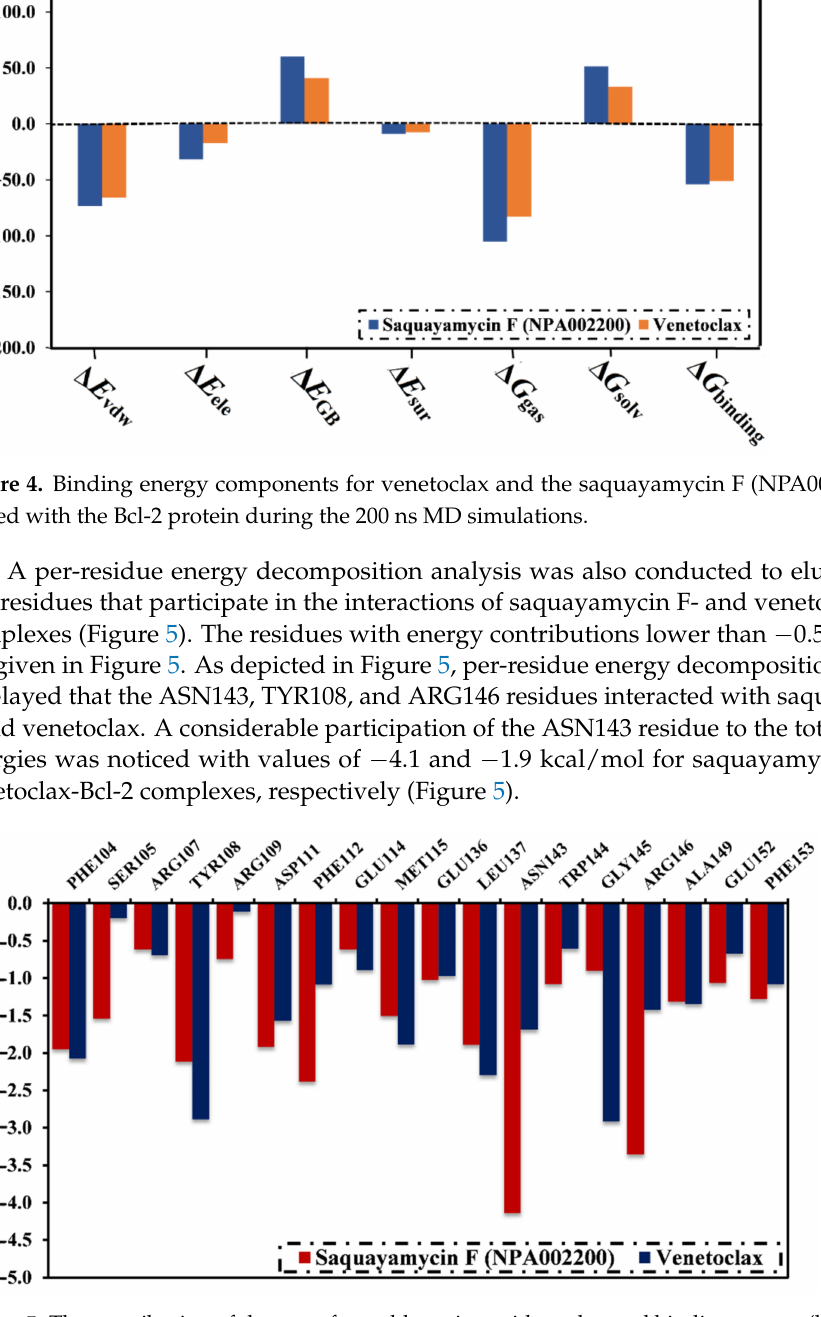
Figure 5. The contribution of the most favorable amino acids to the total binding energy (kcal/mol) of saquayamycin F (NPA002200) and venetoclax with the Bcl-2 protein over 200 ns MD